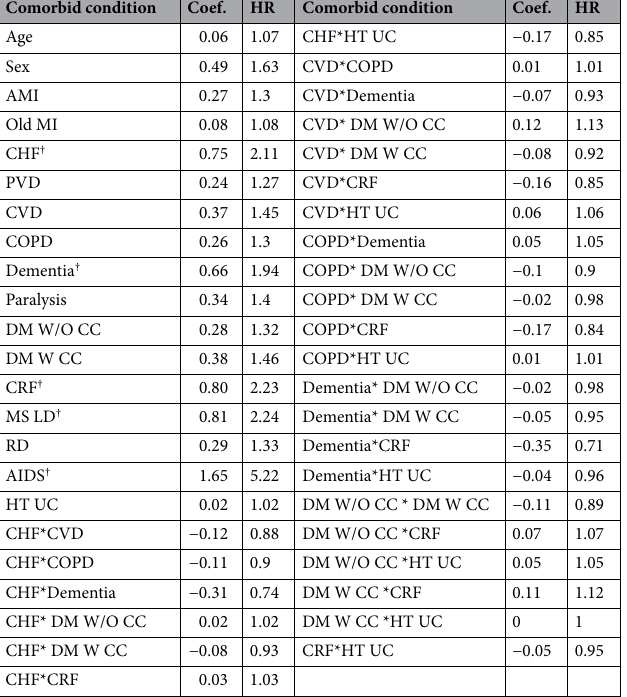
Table 2. Hazard ratios and the coefficients from Negative Deleted Model Main18 & 11.ND based on the training set of Five-Cancer. † The coefficients are at least